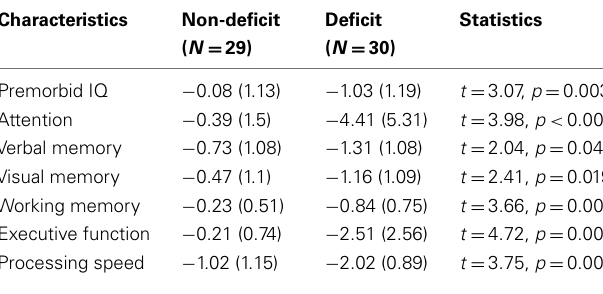
Table 2 | Comparison of neurocognitive groups on neuropsychological variables ( Student’s t- distribution with 58 degrees of freedom).